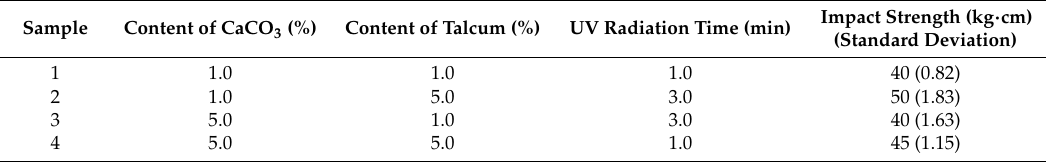
Table 2. Orthogonal experiment of synergistic modification of talcum and calcium